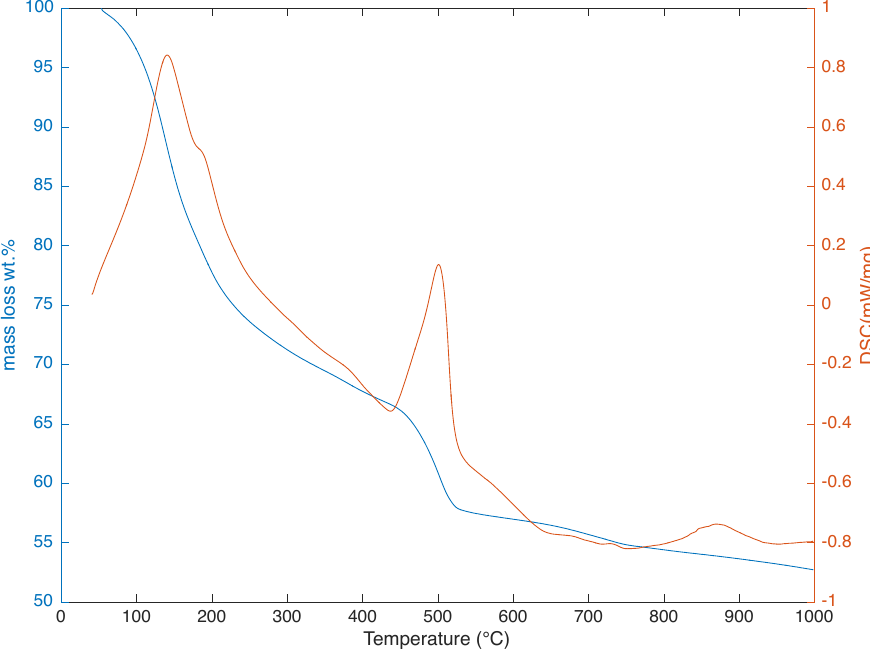
Figure 4. TGA (blue) and DSC (orange) curves of the cement paste used in this study.